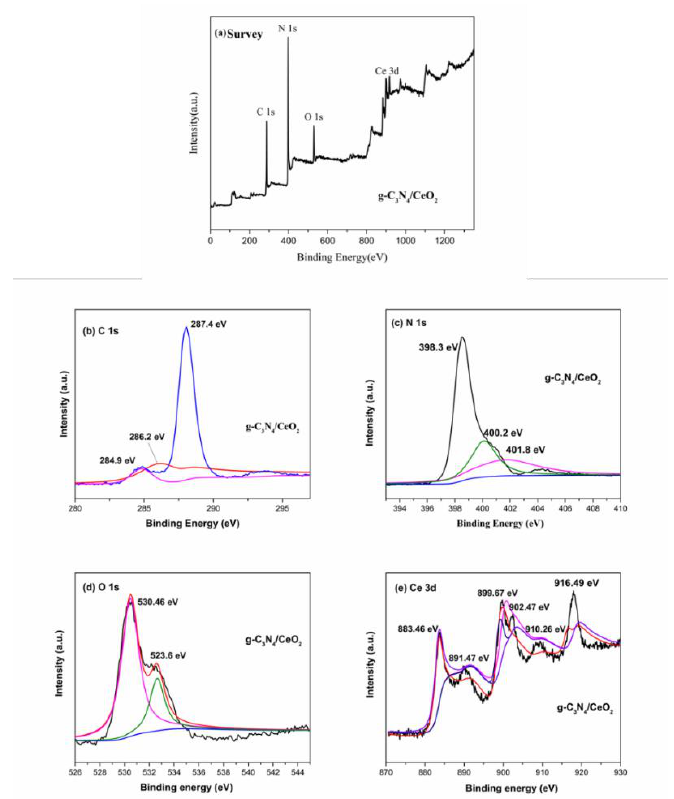
/ CeO 2 : ( a ) survey, ( b ) C 1s, ( c ) N 1s, ( d ) O 1s and ( e ) Ce